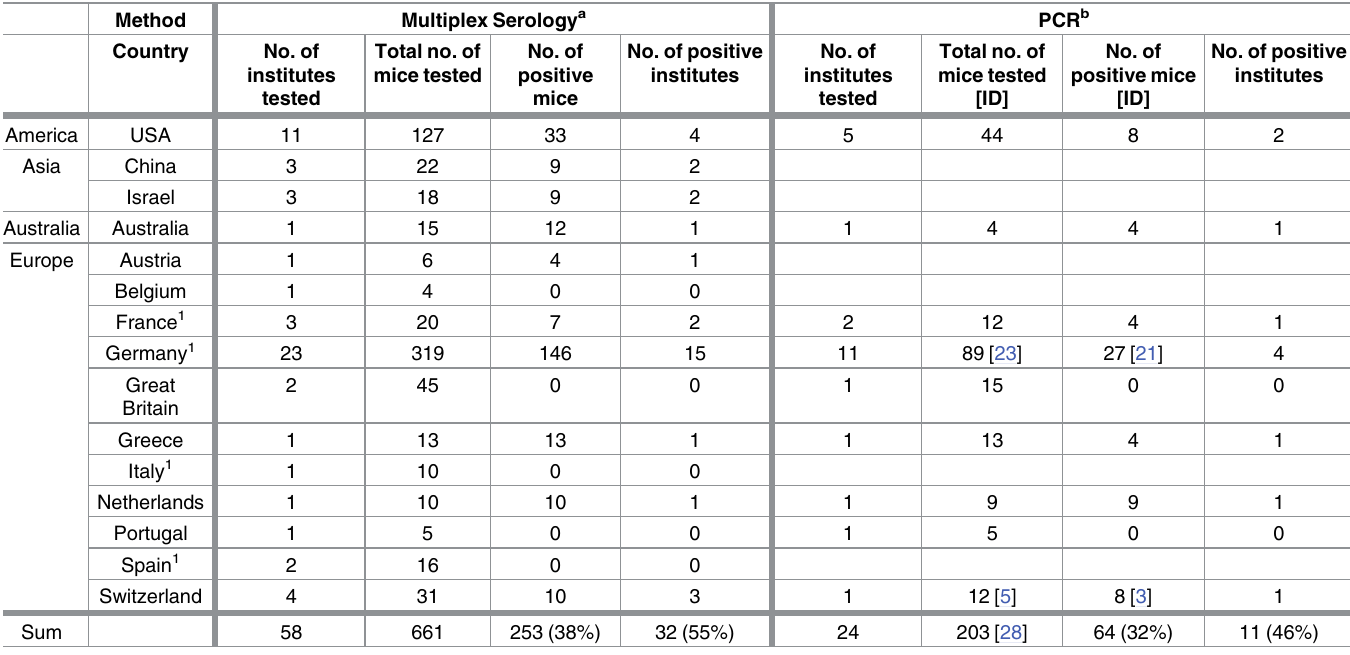
Countries from which animals originate are given in the second